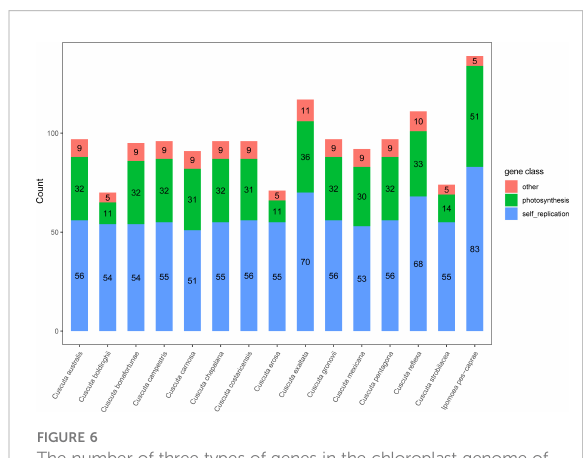
FIGURE 6 The number of three types of genes in the chloroplast genome of Cuscuta species. Red represents genes with other functions, green represents photosynthesis-related genes, and blue indicates genes involved in the self-replication of the chloroplast